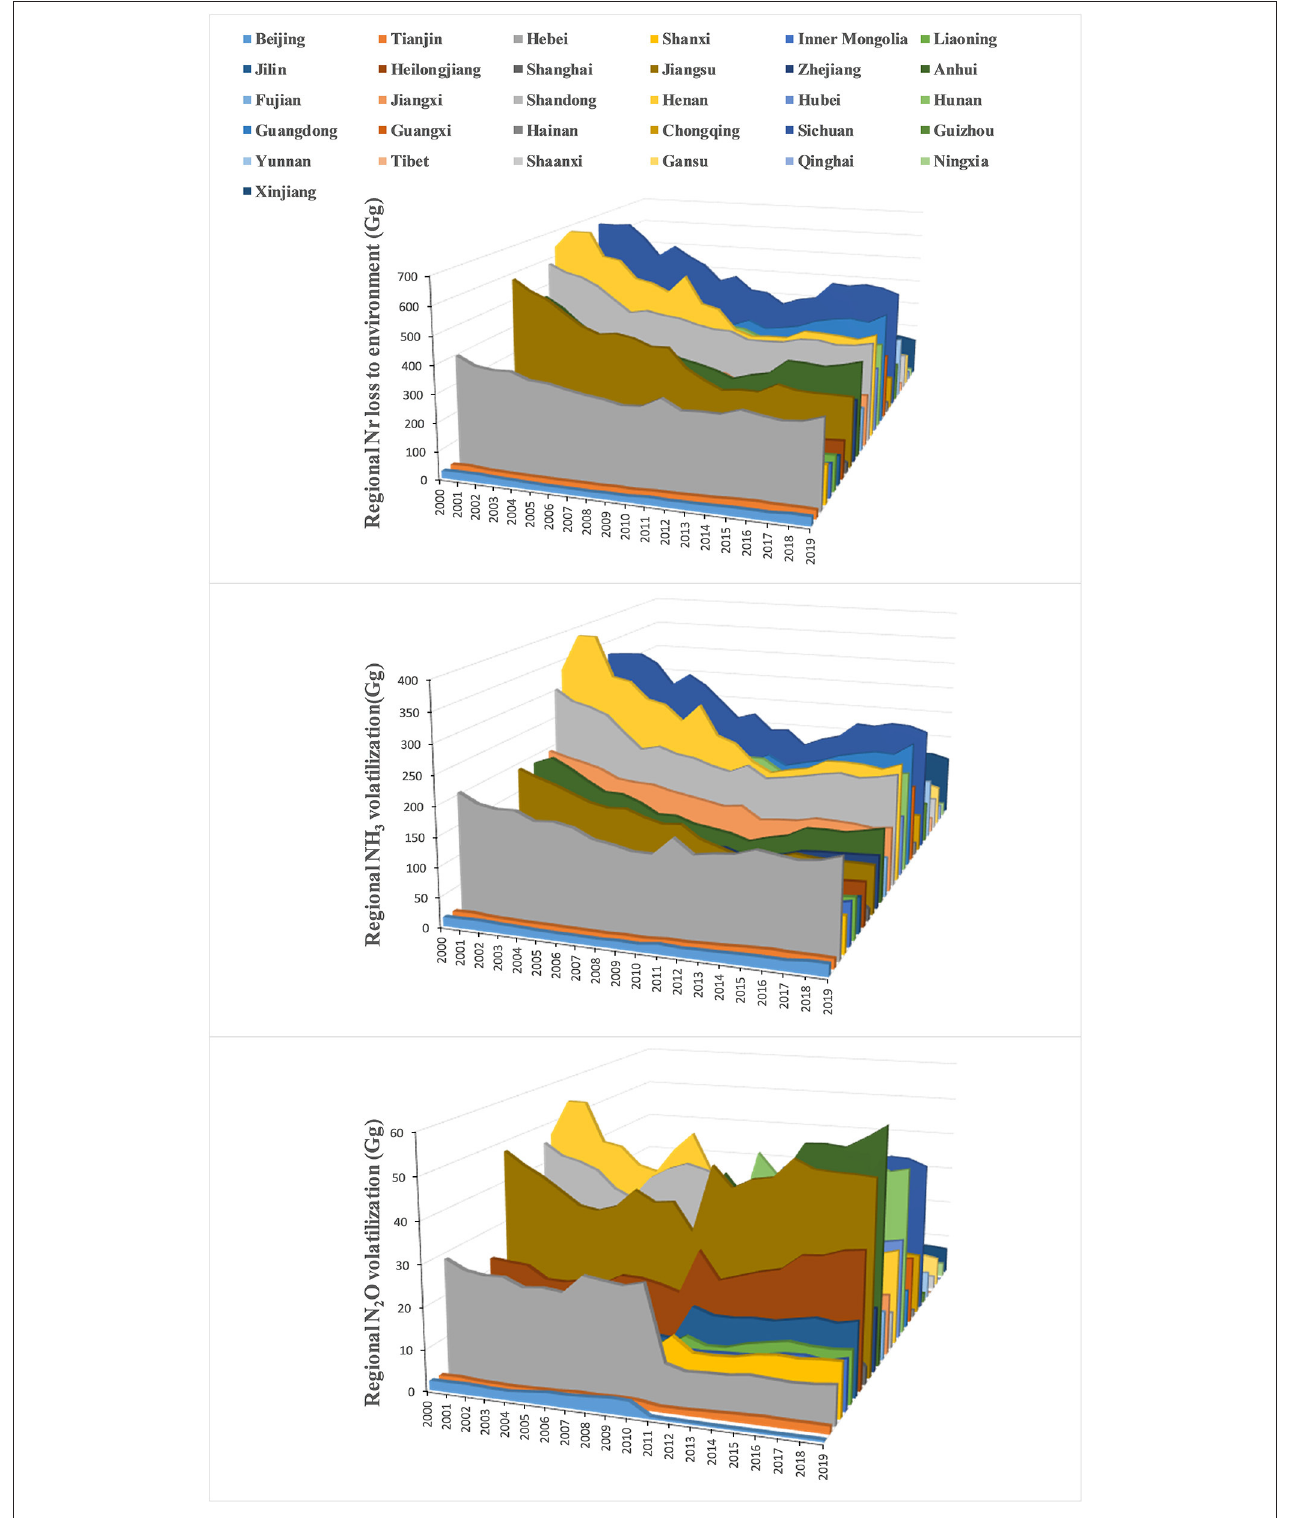
FIGURE 4 | Dynamics in the various Nr loss to environment resulting from regional food NFs related to rural diet from 2000 to 2019.